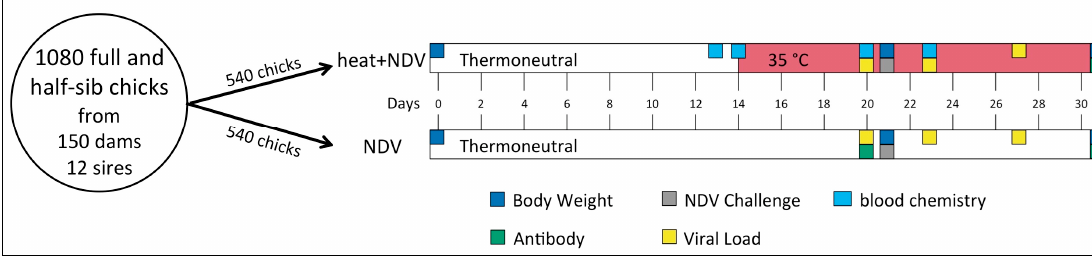
Figure 1. Experimental design. NDV: Newcastle disease virus